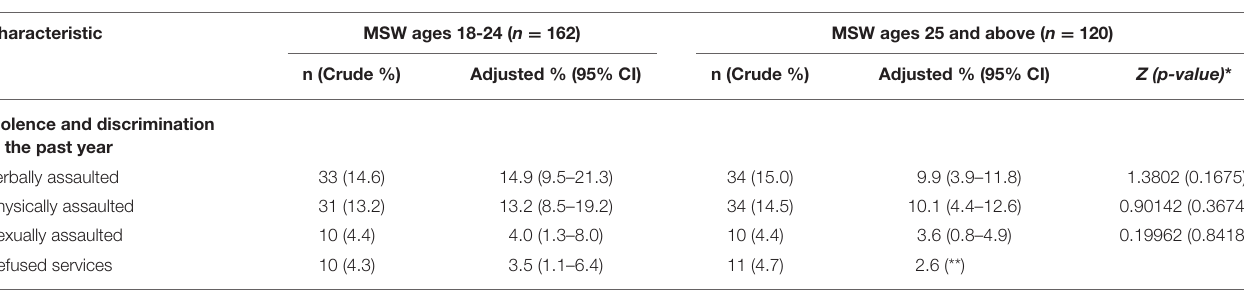
TABLE 5 | Violence and